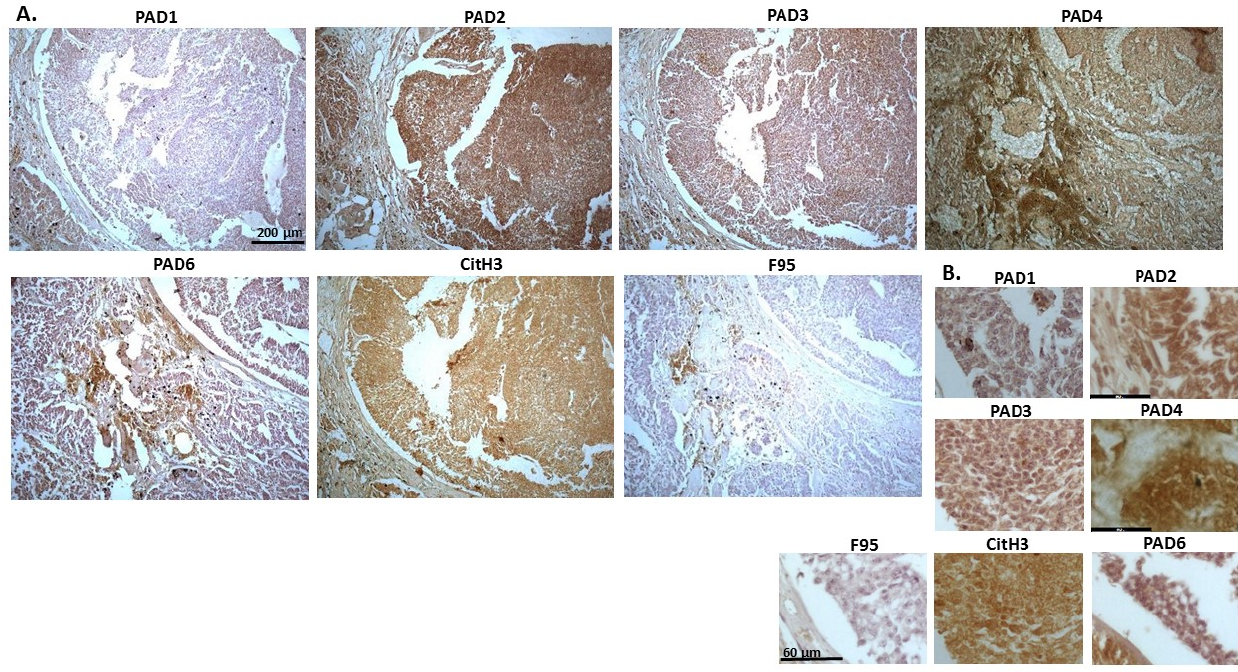
Figure 3. Dog, mixed germ cell-sex cord stromal tumour, testicle. Biopsies from a seven-year old dog, male. ( A ) Overview images for PAD1, 2, 3, 4, 6, CitH3 and F95 stainings of serial tissue sections; scale bar represents 200 μ m for all images; 10× objective. ( B ) Higher magnification shown for each staining from the images in ( A ); scale bar represents 60 μ m for all images; 40× objective.